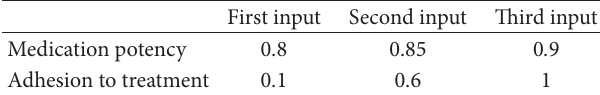
Table 3: Inputs for the FRBS used in simulation.